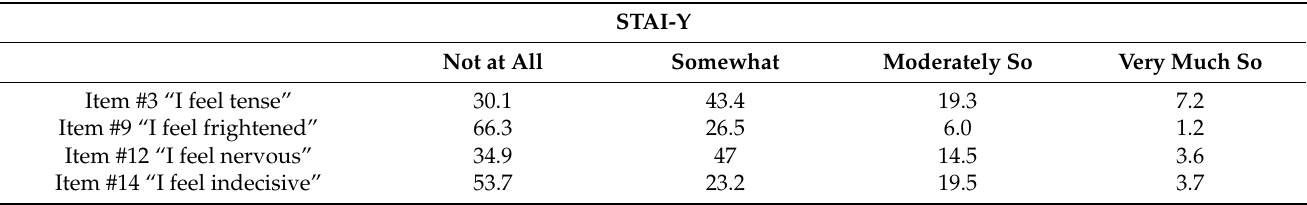
Table 2. Percentage of response frequencies (%) relating to items #3, #9, #12 and #14 of STAI-Y.